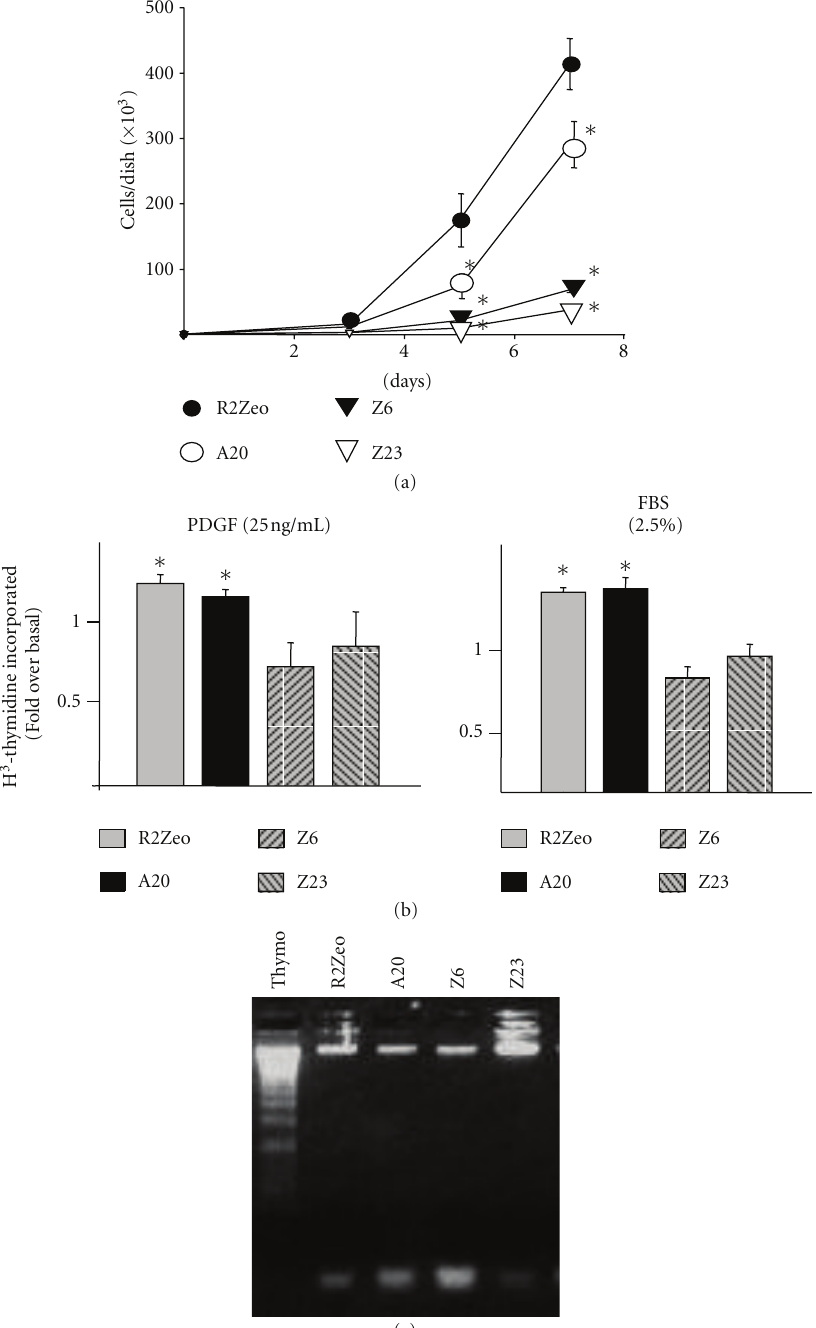
Figure 8: CKI γ 2 overexpression in fibroblasts reduces cell proliferation. (a) Cell proliferation was examined by seeding each cell line in triplicate at 3 × 10 5 cells/60 mm plate on day 0. On days 3, 5, and 7, cells were trypsinized and counted. Results are expressed as the average ± SEM of three independent experiments and for Z6 and Z23, the symbols include the SEM. ∗ Significantly di ff erent at least at P < 0 . 01 as determined by Student’s t -test when compared with R2Zeo cells. (b) Incorporation of 3 H-thymidine in response to PDGF (25ng/mL) or serum (2.5% FBS) stimulation was performed in indicated cell lines. Results are expressed as the fold of thymidine incorporation in presence of PDGF or FBS over basal unstimulated condition and are the mean ± SEM of three independent experiments performed in quadruplicate. ∗ Significantly di ff erent at least at P < 0 . 05 as determined by Student’s t -test compared with respective basal condition. (c) Indicated serum growing cells were submitted to DNA laddering assays according to standard procedures described in Materials and Methods. As positive control for apoptosis, primary rat thymocytes in culture were exposed 24 hours to anisomycin (10 μ